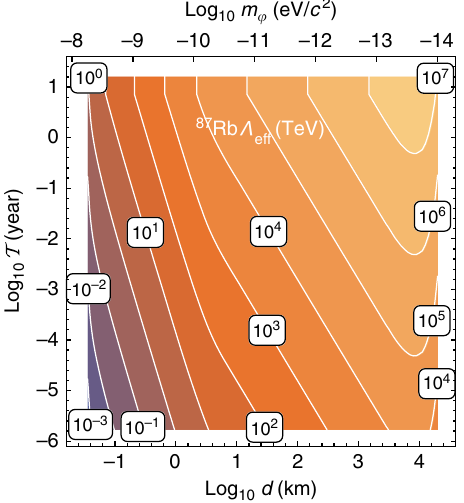
Fig. 4 Results for the effective energy scale. Contour plot showing the 90% con fi dence level exclusion limits on the effective energy scale Λ eff from the Global Positioning System Rb sub-network as a function of the wall width, d , and average time between encounters with domain walls, T . The secondary horizontal axis shows the dark matter fi eld mass, which for topological defects is related to the width via m φ (cid:2) (cid:1) h = dc